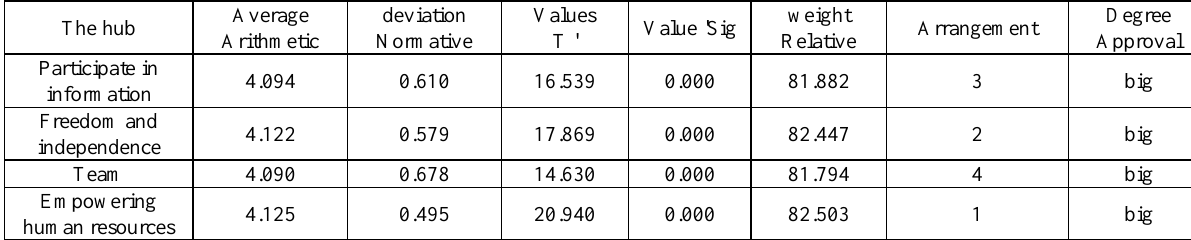
Table 12. Analysis of Human Resources Empowerment Axis Analysis